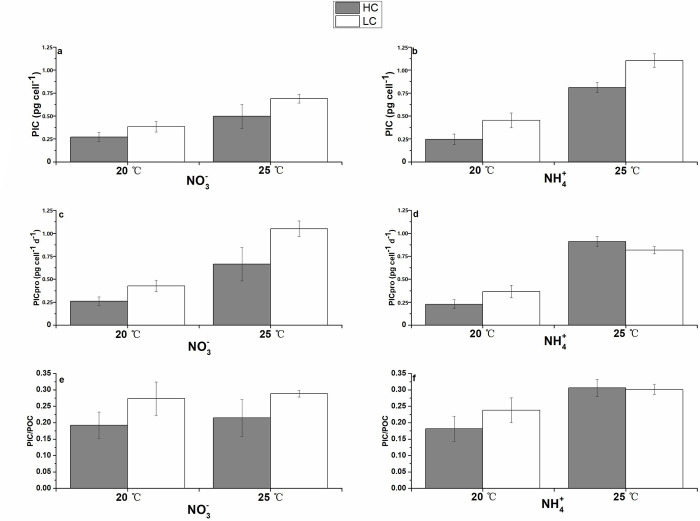
PIC (a, b), PIC production rate (c, d) and PIC/POC (e, f) in NO3— and NH4+-grown cultures under HC (1000 μatm) and LC (400 μatm) at 20°C and 25°C. The values are the means and error bars are standard deviations for triplicate cultures at each treatment (p<0.05).